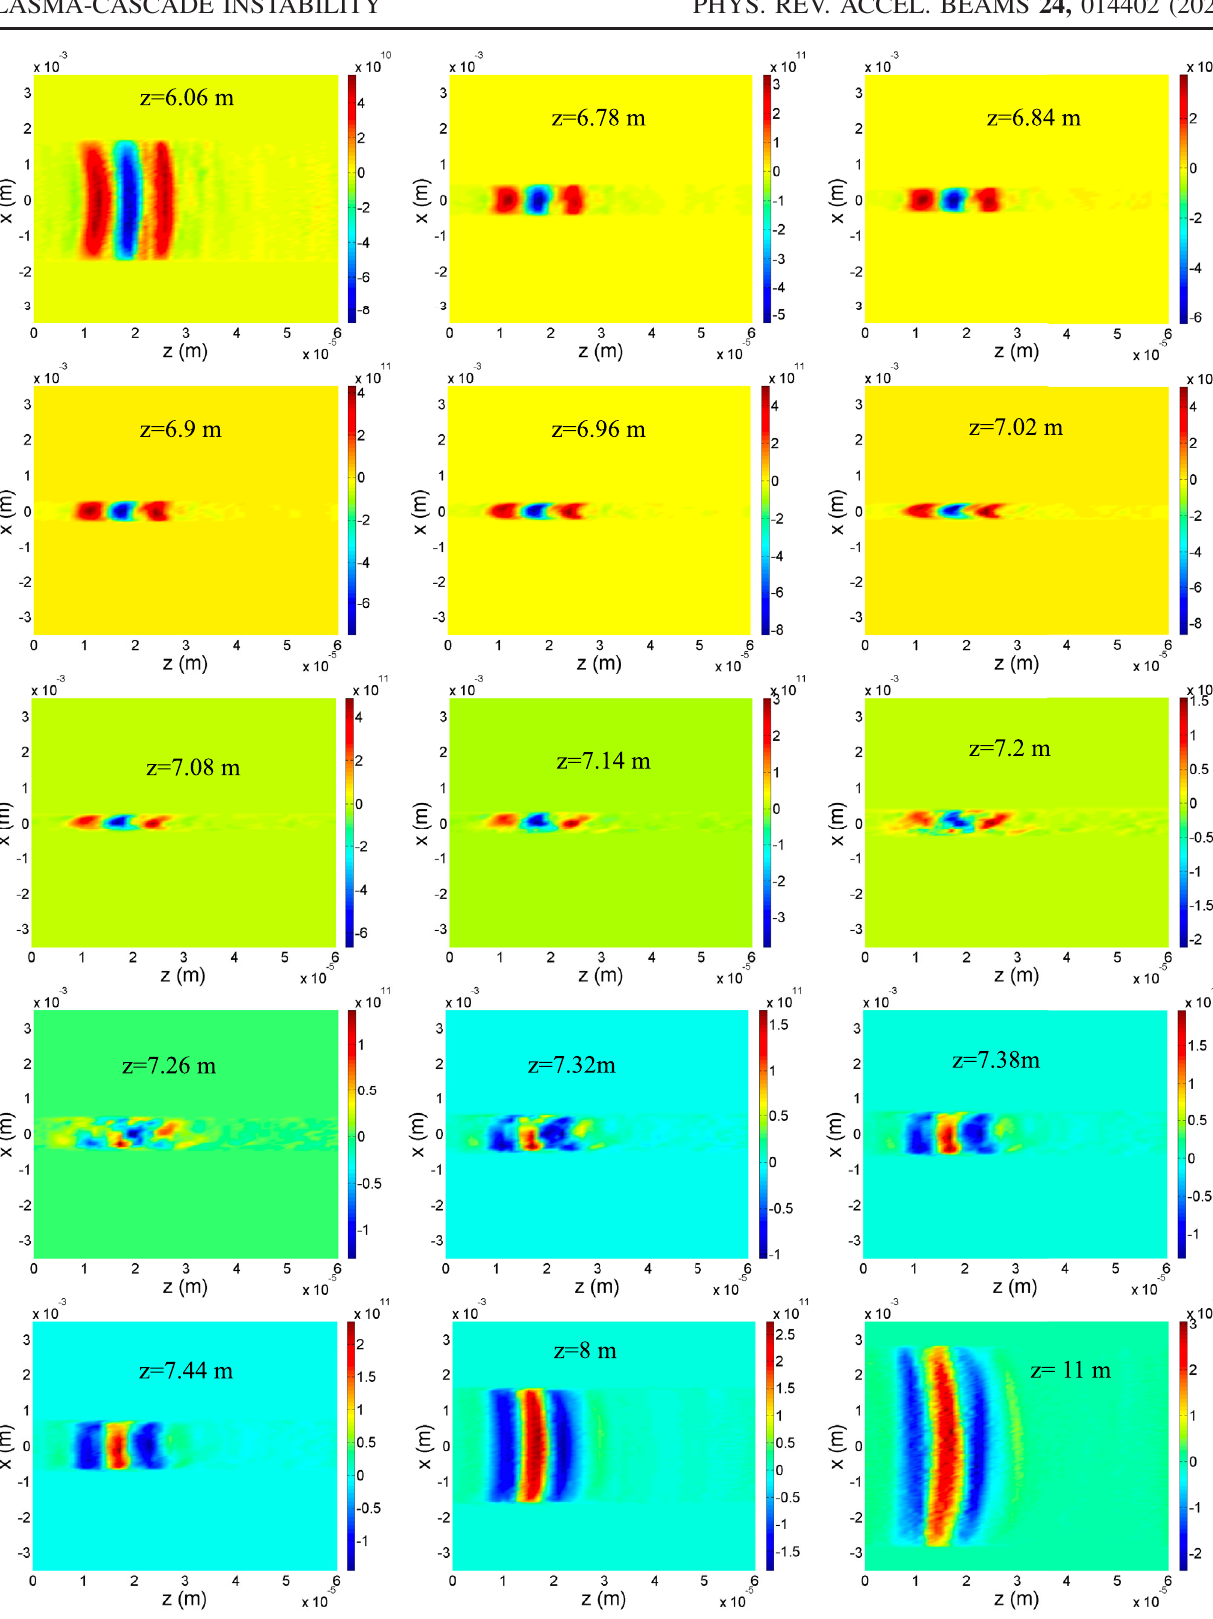
FIG. 12. Case 1: evolution of the single spike in density modulation in the fourth cell of the test PCI lattice (from z ¼ 6 to z ¼ 8 m). The beam was then propagated for 3 meters of free space resulting in well-defined structure shown in the last profile. Density modulation of the center slice has the same sign as at the entrance with 100-fold increase in the